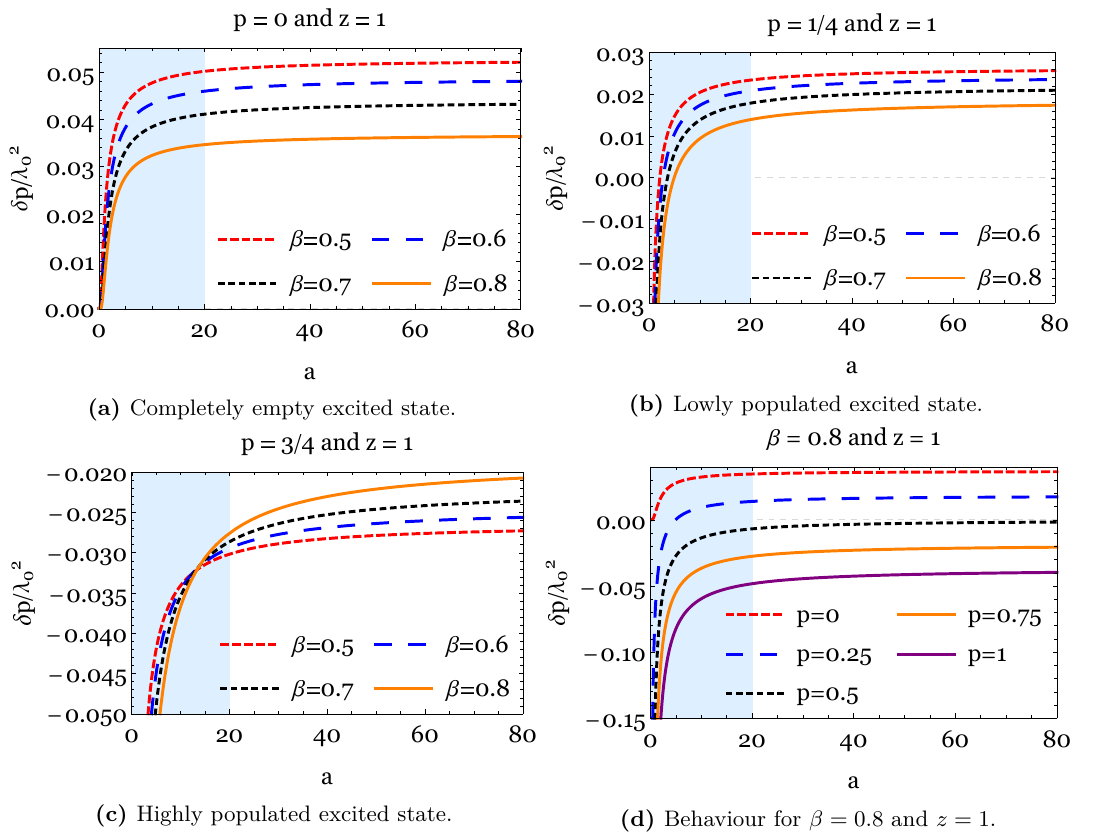
Figure 5. Behaviour of the transition probability with respect to reduced acceleration a in the intermediate boundary regime for various values of p and β